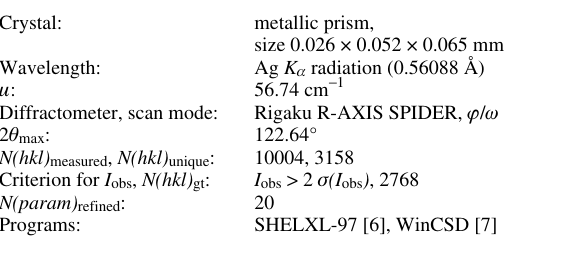
Table 1. Data collection and handling.